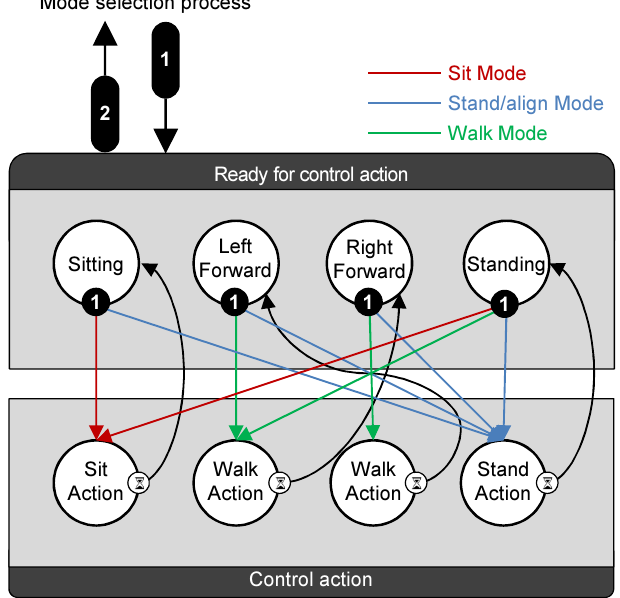
Figure 7. State transition rules in the physical layer (in Figure 6) given the selected mode.